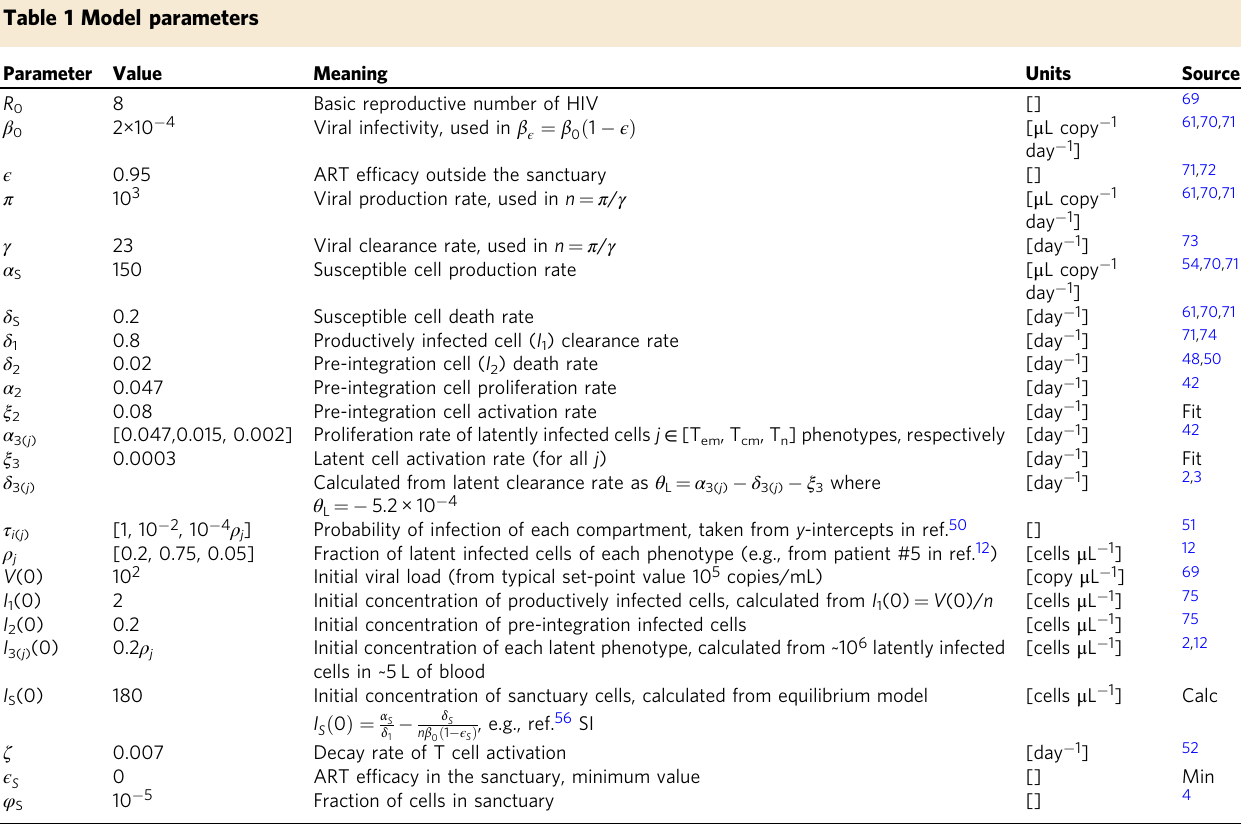
Table 1 Model parameters Parameter